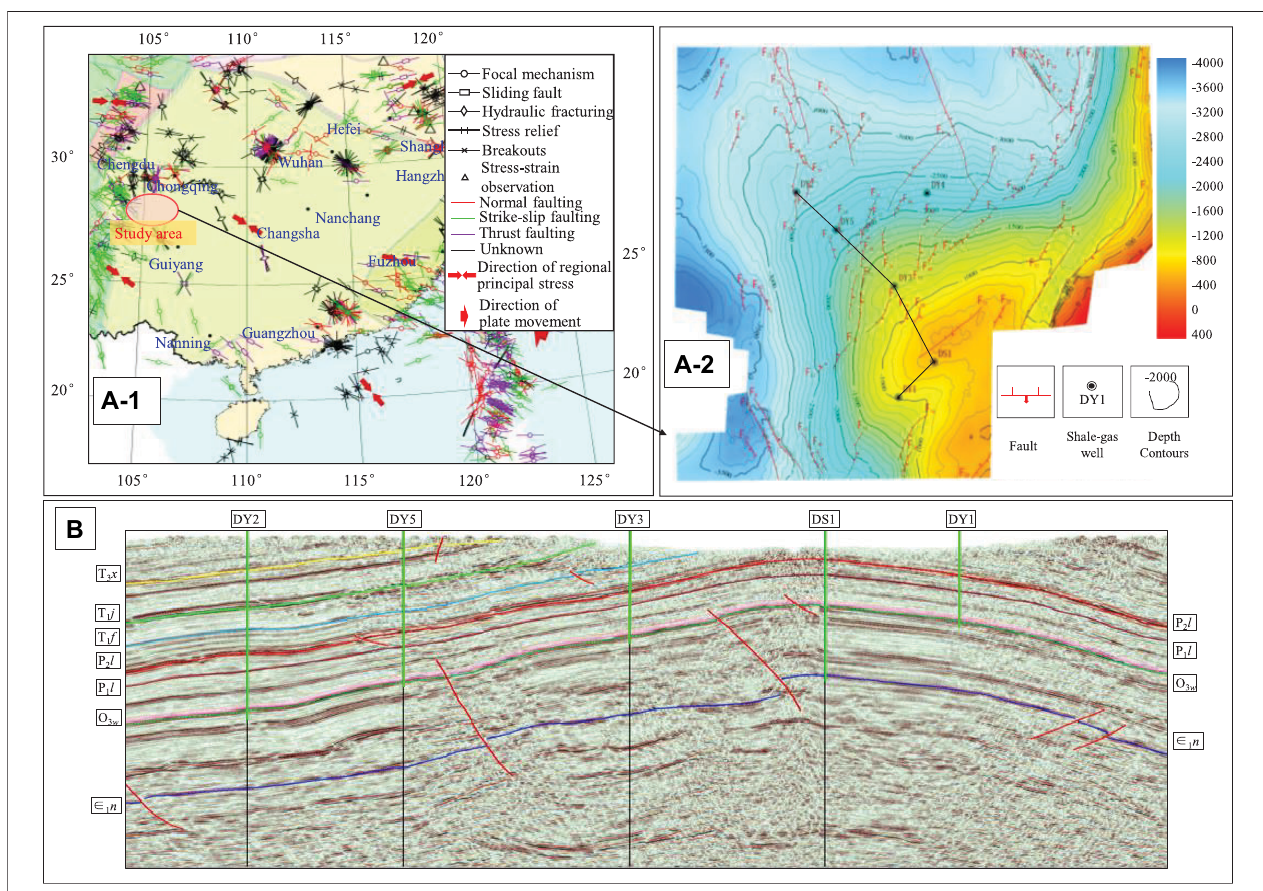
FIGURE 1 | [(A), 1,2] Location of the Dingshan area and (B) Cross-section through the Dingshan area (Liu et al., 2017b; Hu et al., 2019) (The crustal stress data were provided by the China Earthquake Data Center).